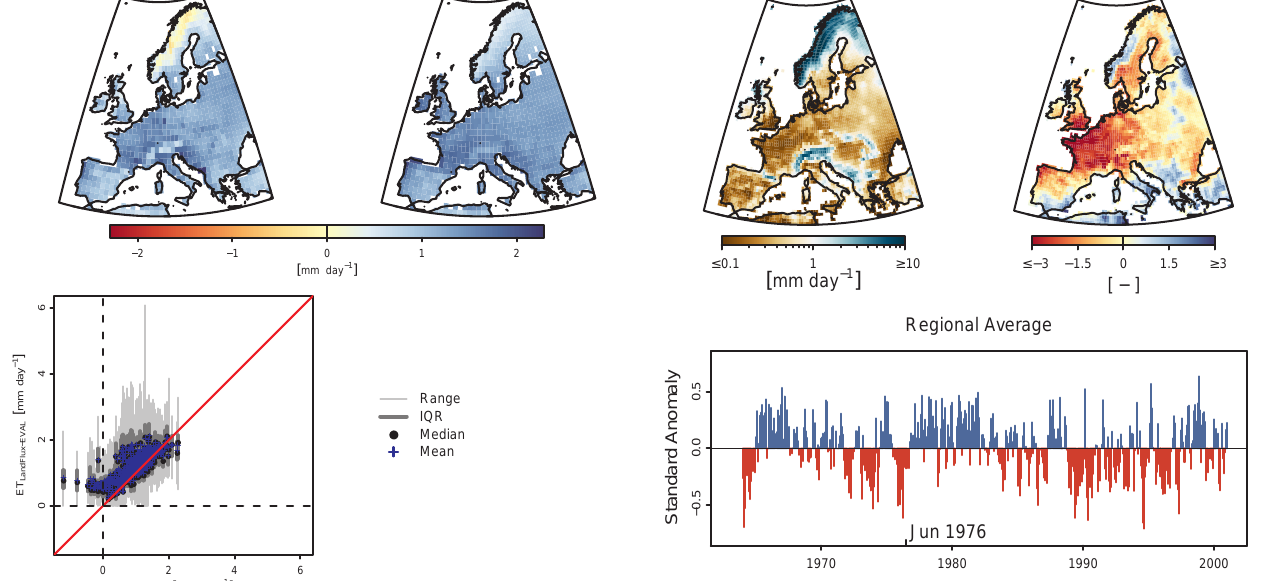
Figure 11. Comparison of mean evapotranspiration (1989–1995) derived from the random forest model with full atmospheric forcing and the LandFlux-EVAL synthesis product. Top left: mean evap- otranspiration computed as the mean difference between precipi- tation and runoff derived from the RFM. Top right: mean evapo- transpiration from the LandFlux-EVAL synthesis product (Mueller et al., 2013). Bottom: comparison of the RFM and the LandFlux- EVAL estimates of mean evapotranspiration. The vertical bars de- note the interquartile range (IQR) and the range of all 40 data sets entering the LandFlux-EVAL product. The points and crosses in- dicate the median and mean evapotranspiration of the LandFlux- EVAL product.